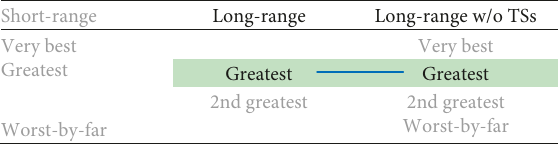
Table 15: Tabular representation of Rule 6a.